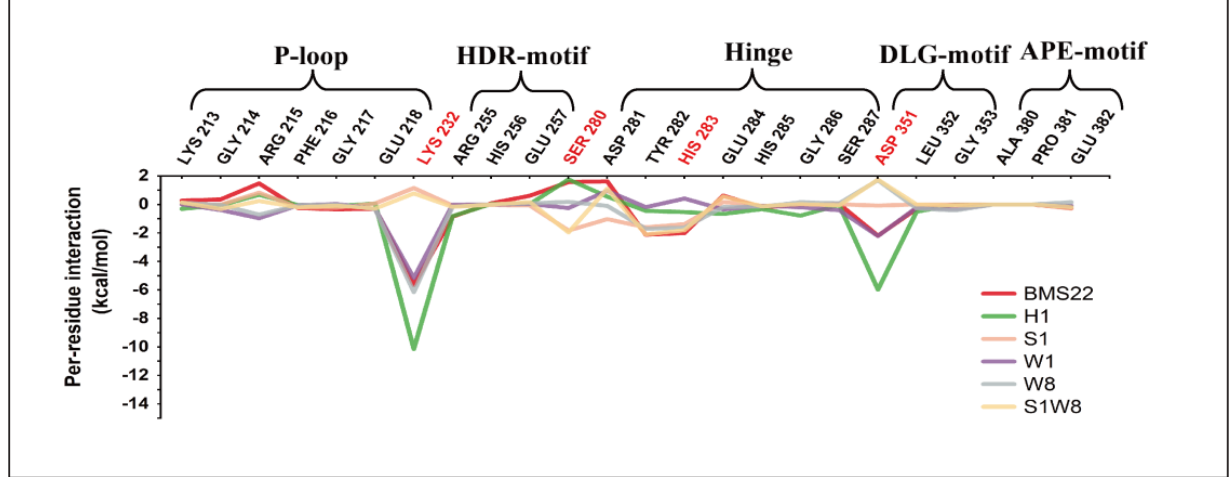
Figure 9. Contributions of free energy calculated by MM/PBSA method for key residues of TGFβR Ⅰ .